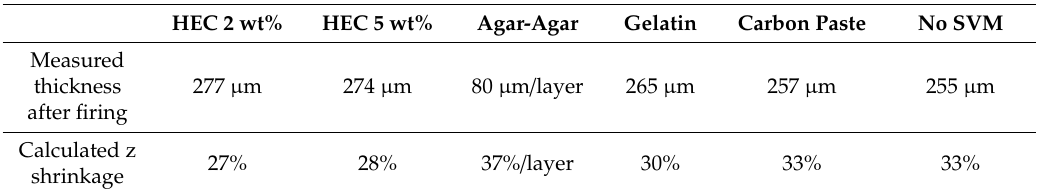
Table 2. Vertical shrinkage (final value after firing compared to thickness after stacking of three layers of Ferro A6M-E 5 mil tape, i.e., 381 µm.